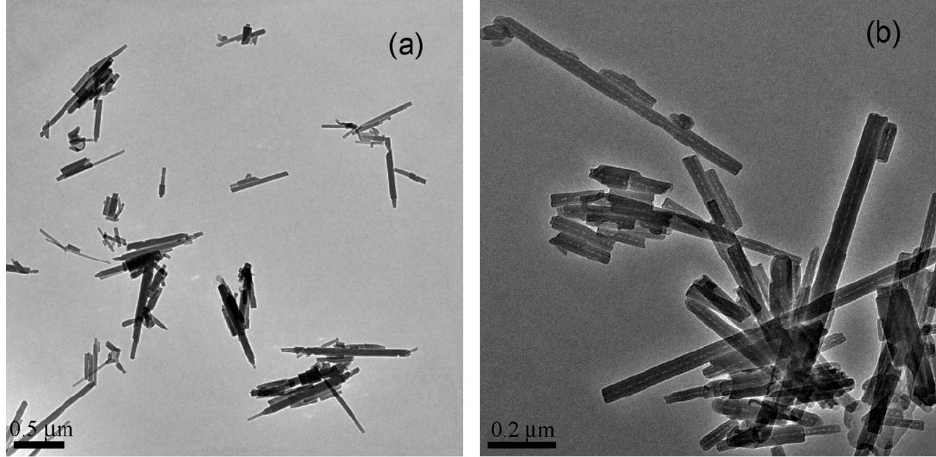
Figure 19. TEM of the NTs obtained at various magnifications: ( a ) Low and ( b ) High. 85 × 173 mm (300 × 300 DPI) [130].